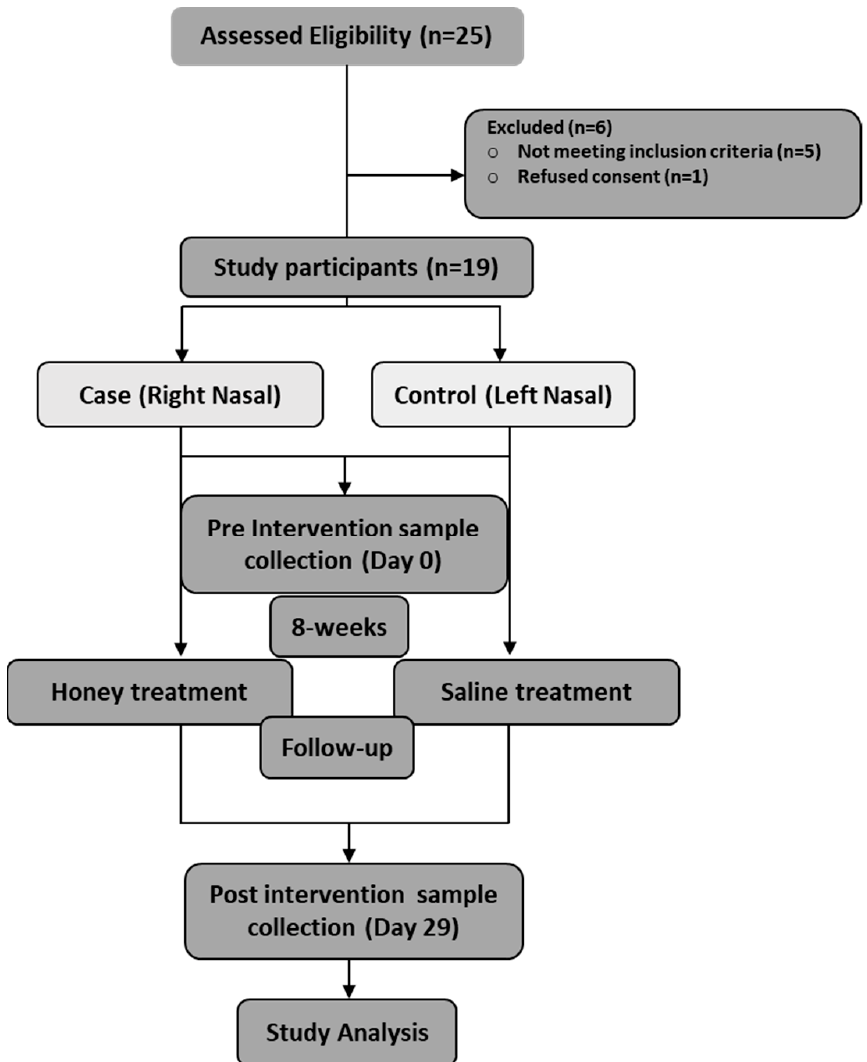
Figure 1. CONSORT: screening and enrolment of study participants.